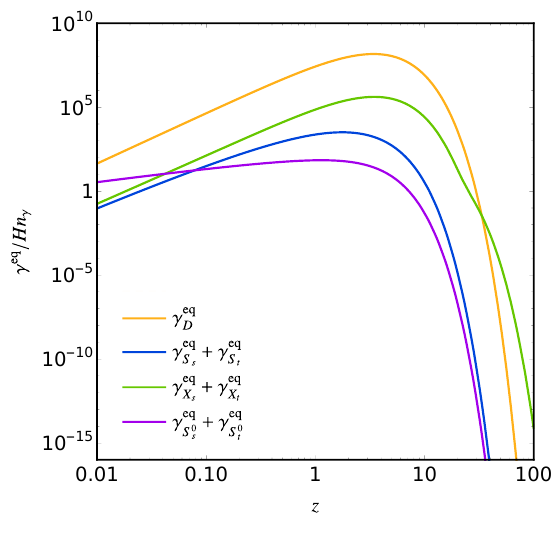
Figure 19 . Equilibrium decay and scattering rates with respect to z = m X 0 . 05 for the low-scale scenario with m The solid orange line shows the decay rate of X lines show the scattering rates S